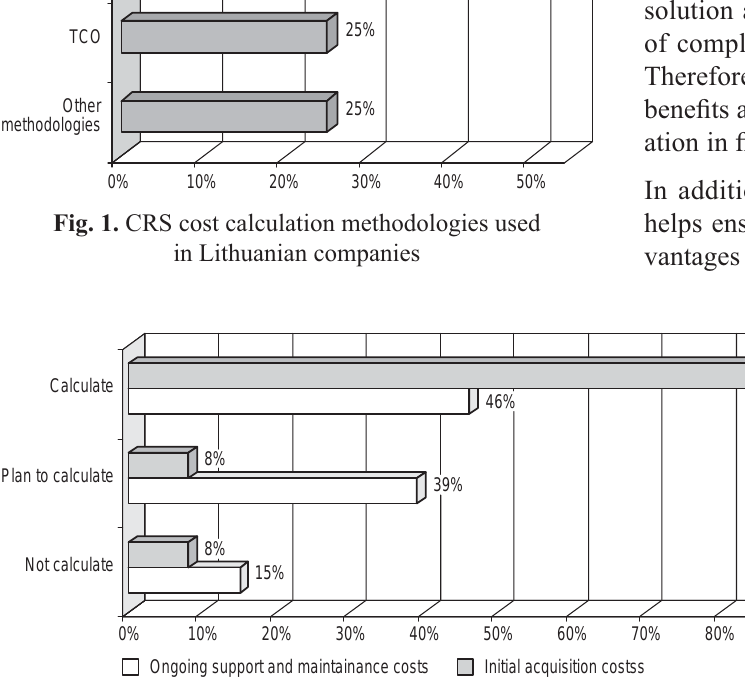
Fig. 2. Cost calculation of CRS initial acquisition and ongoing support and maintenance in Lithuanian companies